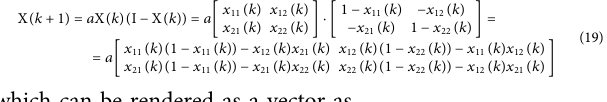
Figure 13 , we report the phase portraits x x 21 , and x 11 − x 22